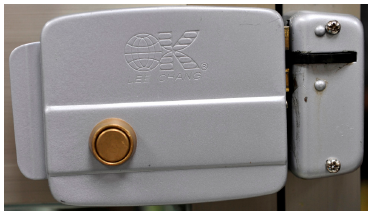
Figure 12. Door lock that can be controlled automatically and manually